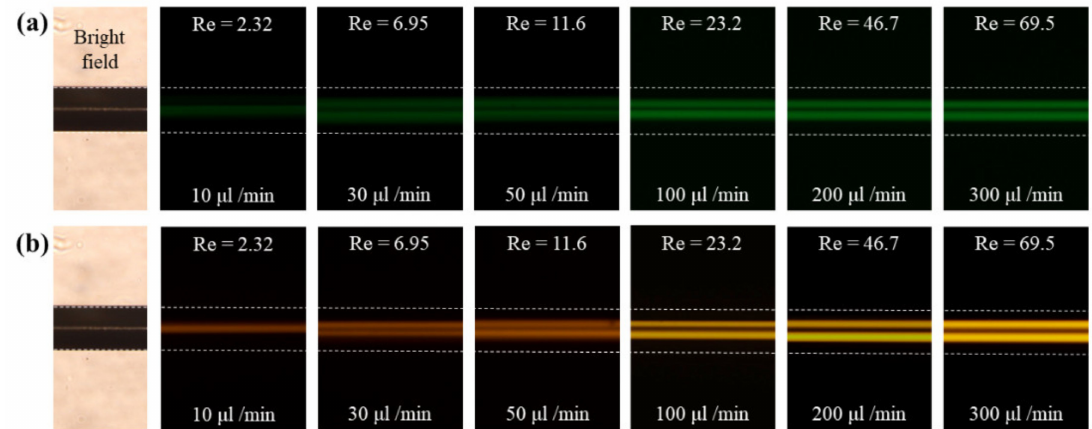
Figure 3. Fluorescence image of the flow through the rhombic microchannel in the Newtonian fluid at various flow rates: ( a ) 5 µ m particles and ( b ) 13 µ m particles.